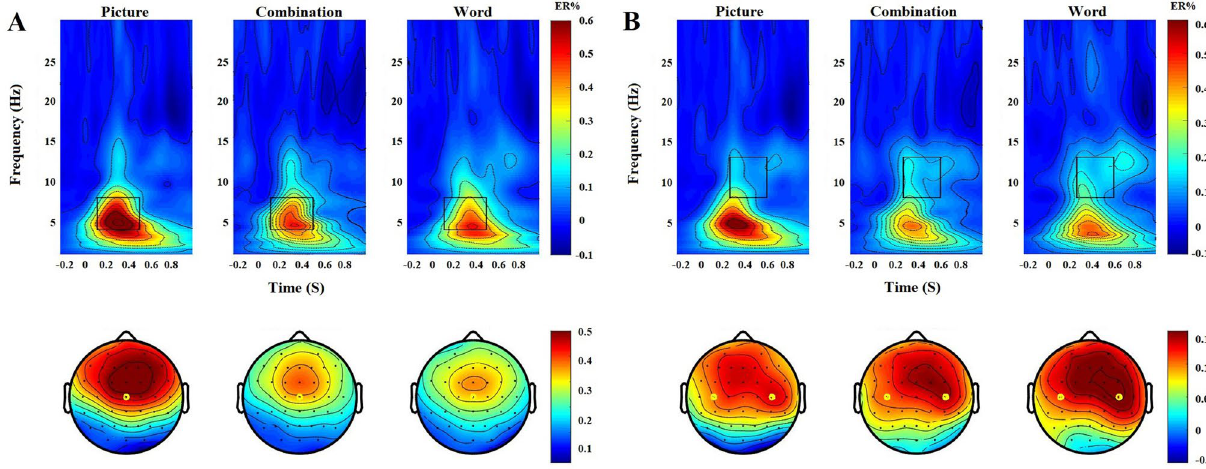
Figure 8. Difference oscillation in the Go/No-go task: ( A ) time–frequency distribution of theta-band activity; ( B ) time–frequency distribution of mu-band